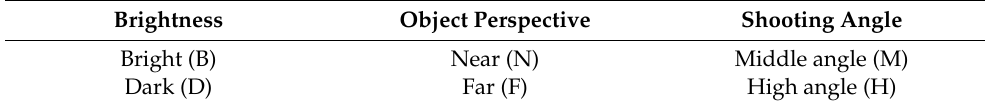
Table 3. Video classification